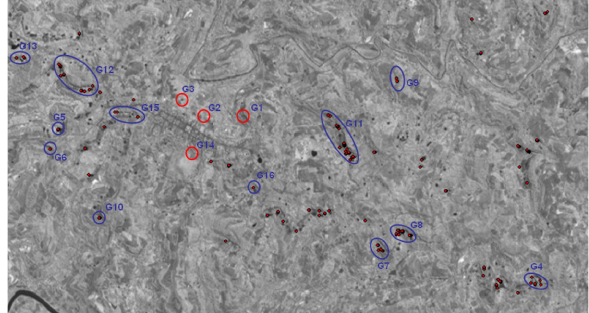
Figure 10. Mining residues/basalt overlapping the Aster band